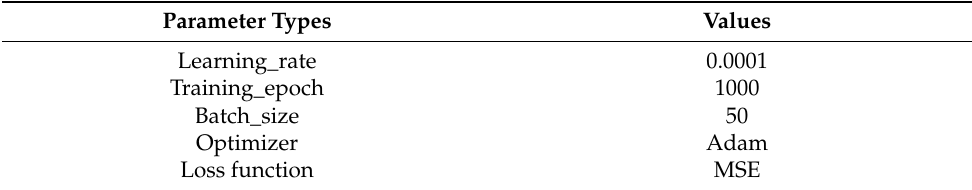
Table 1. Configured hyperparameters for deep neural network (DNN) model.